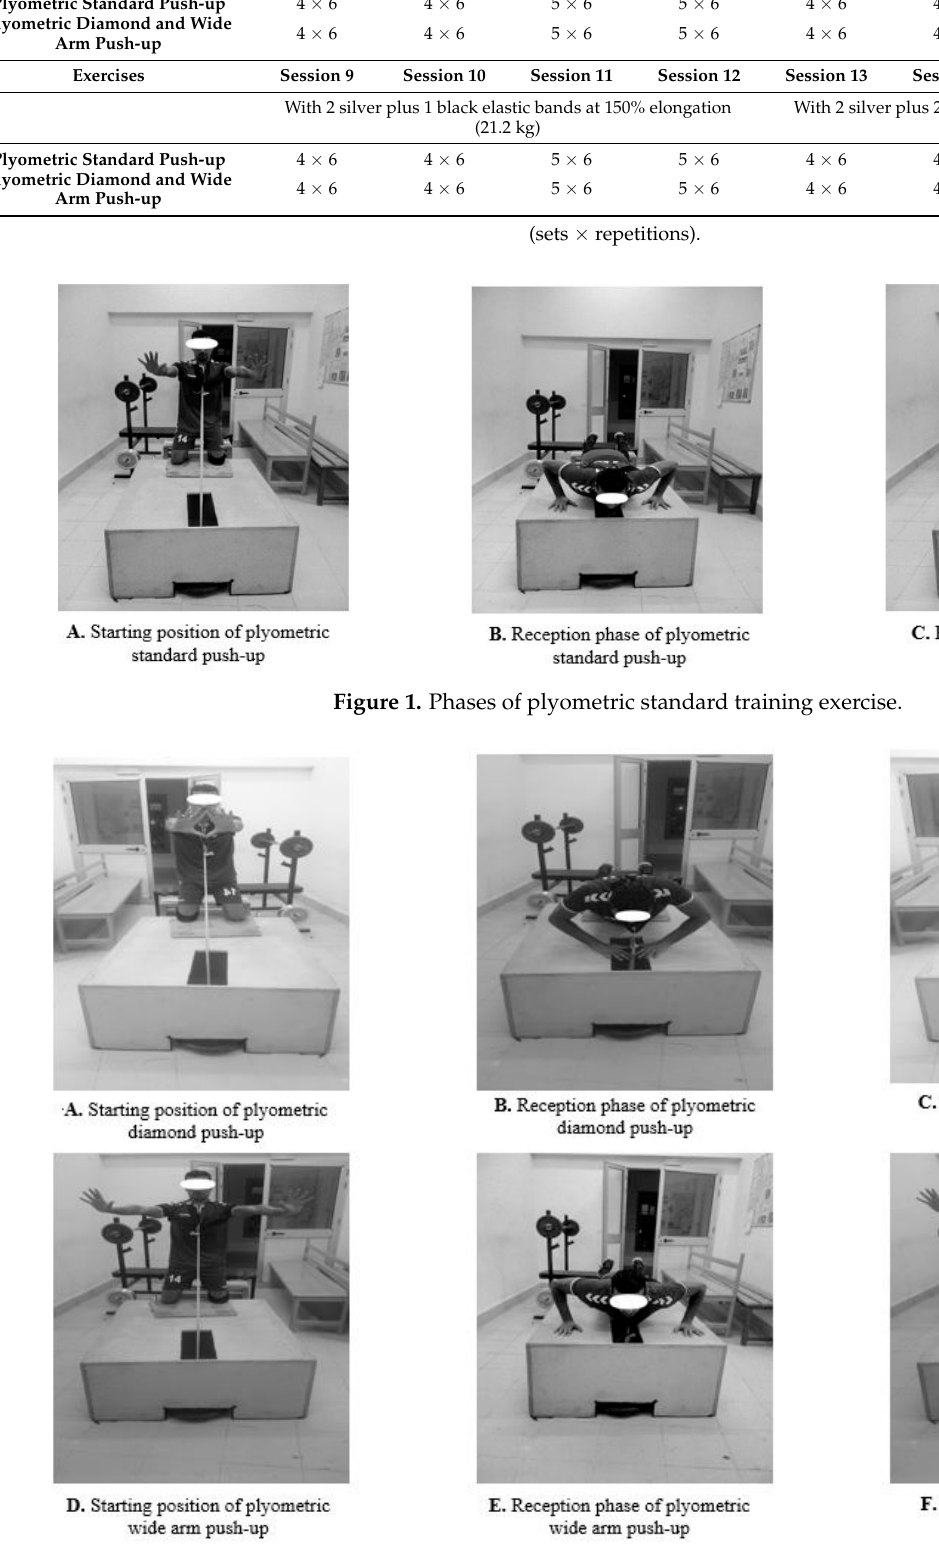
Figure 2. Phases of plyometric diamond and wide arm push-up training exercise.